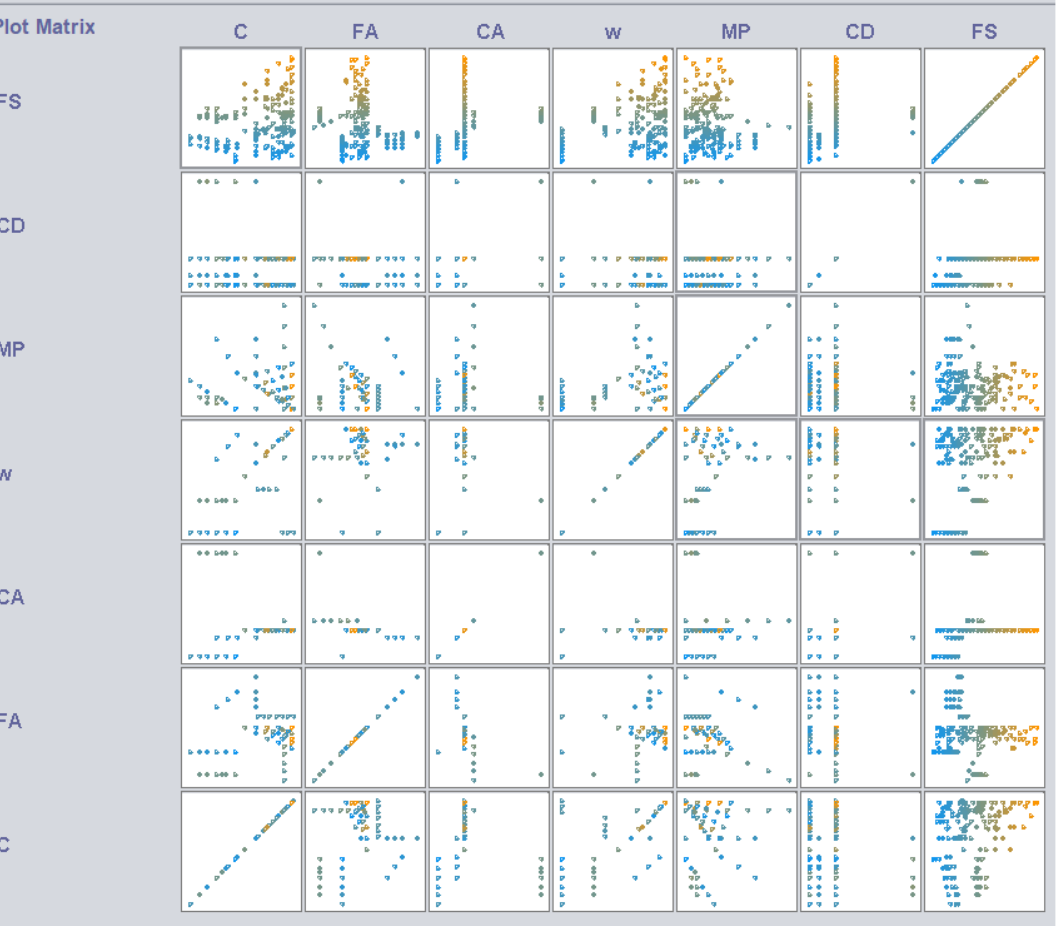
Figure 5. Pair Plot of all Variables.